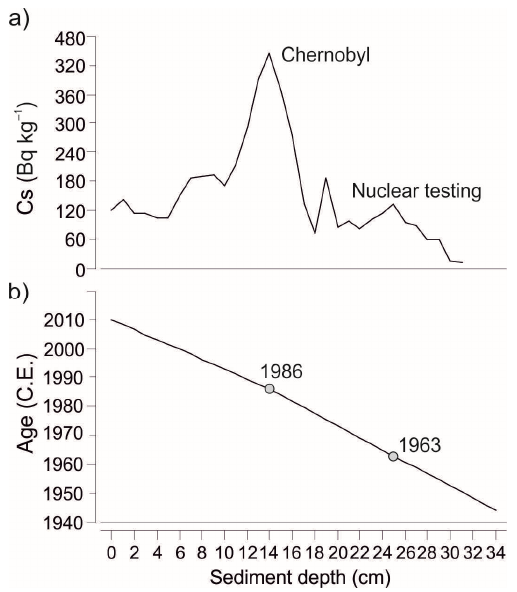
Figure 3. ( a ) 137 Cs activity and ( b ) an age-depth model for the Lake Maggiore sediment core. Peak activities of Chernobyl nuclear disaster (year 1986) and nuclear weapon testing (1963) are